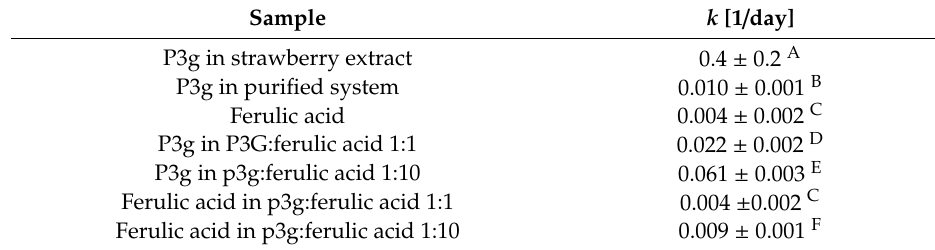
Table 4. Pelargonidin-3- O -glucoside (p3g) and ferulic acid degradation rates during shelf-life study at 37 ◦ C, in a citric bu ff er of pH = 3, 50 mM. Molar ratios of 1:1 and 1:10 between pelargonidin-3- O -glucoside and ferulic